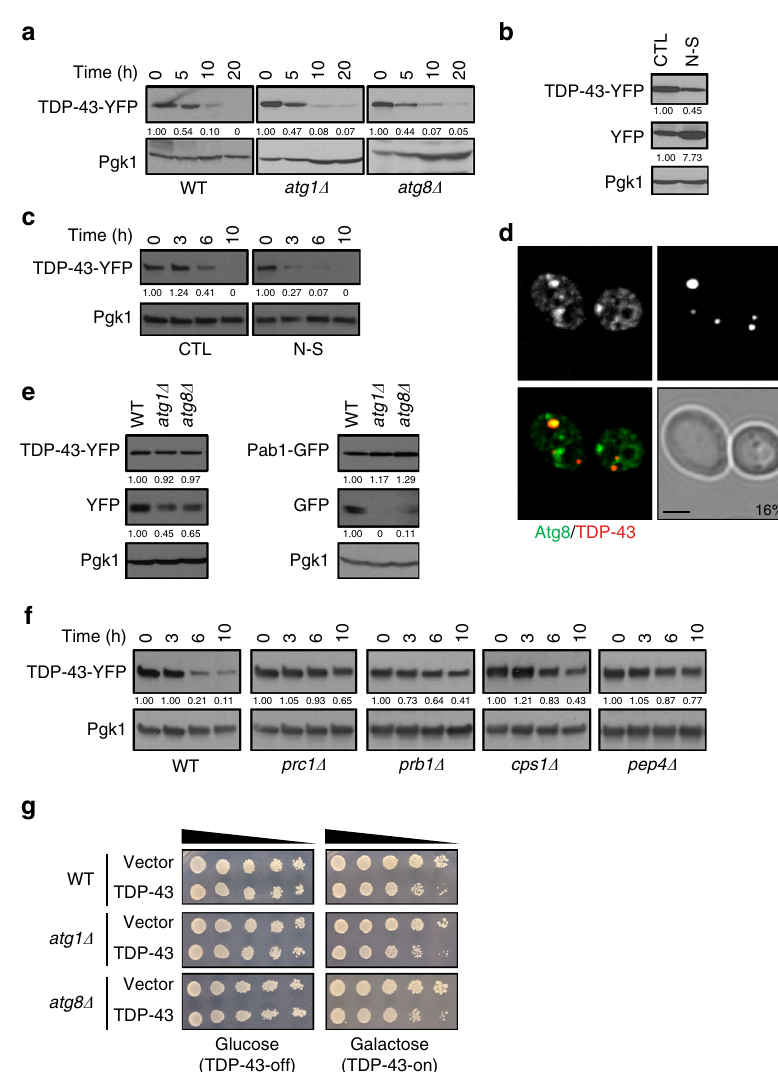
Fig. 1 TDP-43 toxicity and turnover in yeast are only modestly affected by autophagy. a Turnover of TDP-43-YFP protein in WT and null strains in mid-log phase. Time indicates period following GAL1- transcriptional shut off. TDP-43-YFP protein level was quanti fi ed relative to a Pgk1 loading control. b Vacuolar degradation of TDP-43-YFP in WT cells in mid-log phase, +/ − 4 h nitrogen starvation (N-S), assessed by accumulation of free YFP fragment. Protein levels quanti fi ed as above. c Turnover of TDP-43-YFP in WT cells in mid-log phase, +/ − N-S. Time indicates period following CHX addition (0.2 mg/ml). Protein levels quanti fi ed as above. d WT strain was transformed with TDP-43-mRuby2 and GFP-Atg8. % value indicates co-localization of TDP-43 foci with Atg8. Scale bar = 2 µ m. e Indicated strains transformed with TDP-43-YFP or Pab1-GFP were harvested and vacuolar free YFP/GFP was detected. Protein levels quanti fi ed as above. f Turnover of TDP-43-YFP indicated strains (vacuolar protease mutants) examined as in c . g Serial dilution growth assay of WT and indicated isogenic null strains expressing vector or